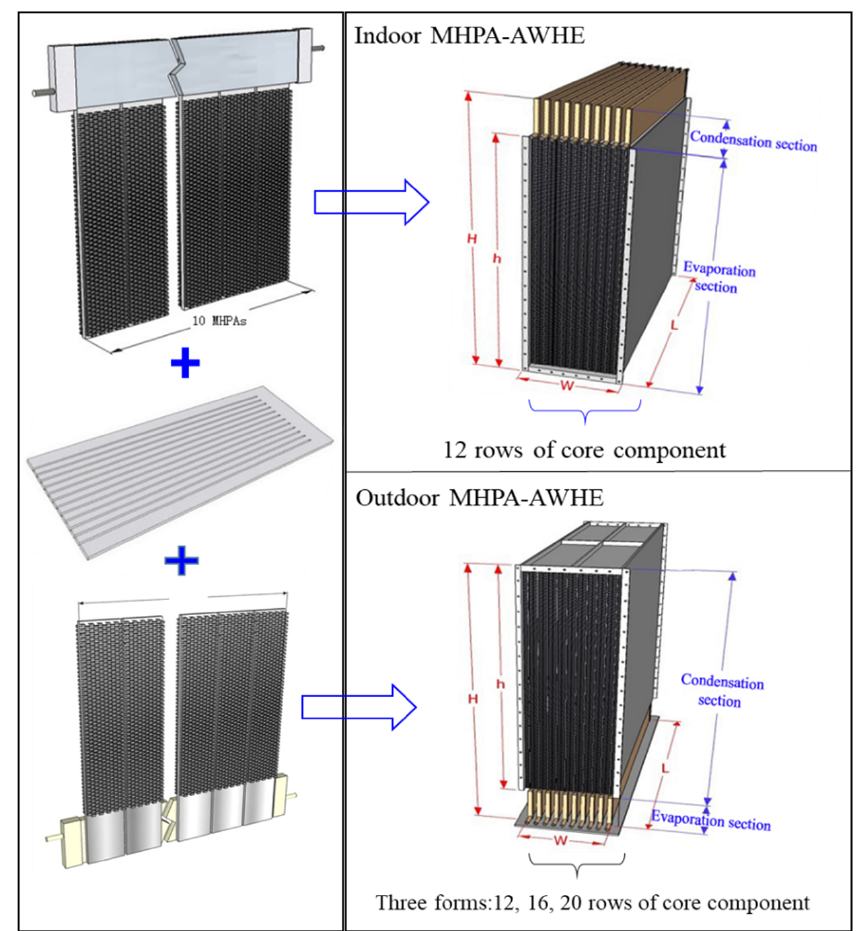
Figure 3. Heat transfer unit of MHPA–AWHE: ( a ) structure of PFT; ( b ) photo of heat transfer components.